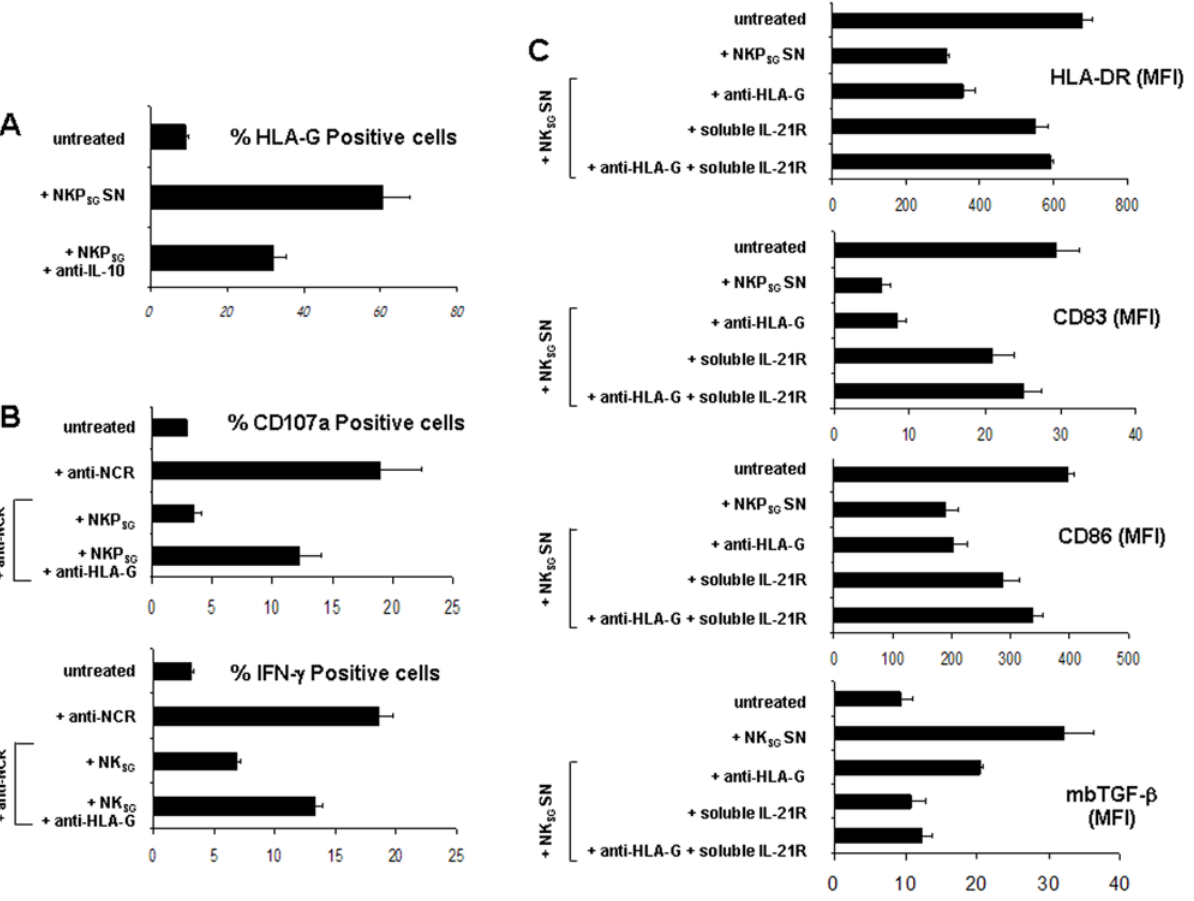
Figure 9. IL-10, IL-21 and HLA-G secreted by NKP SG cells act as immuno-regulatory factors. (A) Effect of incubation with neutralizing anti- IL-10 mAbs (10 m g/ml) on the percentage of HLA-G positive human PB monocytes treated or not (untreated) with the cell supernantants from NKP SG cells. (B) Effects of the incubation with neutralizing anti-HLA-G mAbs (10 m g/ml) on the percentage of CD107a and IFN- c on PB-derived NK positive cells triggered with NCR cross-linking in the presence or not of NKP SG cells. (C) Effects of the incubation with neutralizing anti-HLA-G mAb and/or soluble IL-21R (10 m g/ml) on the expression intensity (Mean Fluorescence Intensity) of HLA-DR, CD83, CD86 and mb-TGF- b on LPS-activated DC cultured or not with cell supernantants from NKP SG cells.